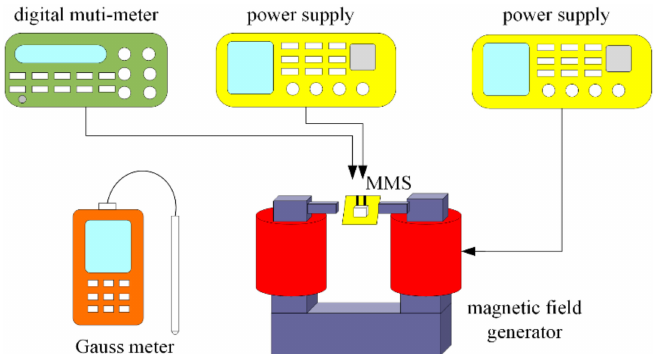
Figure 7. Experimental setup for the MMS.